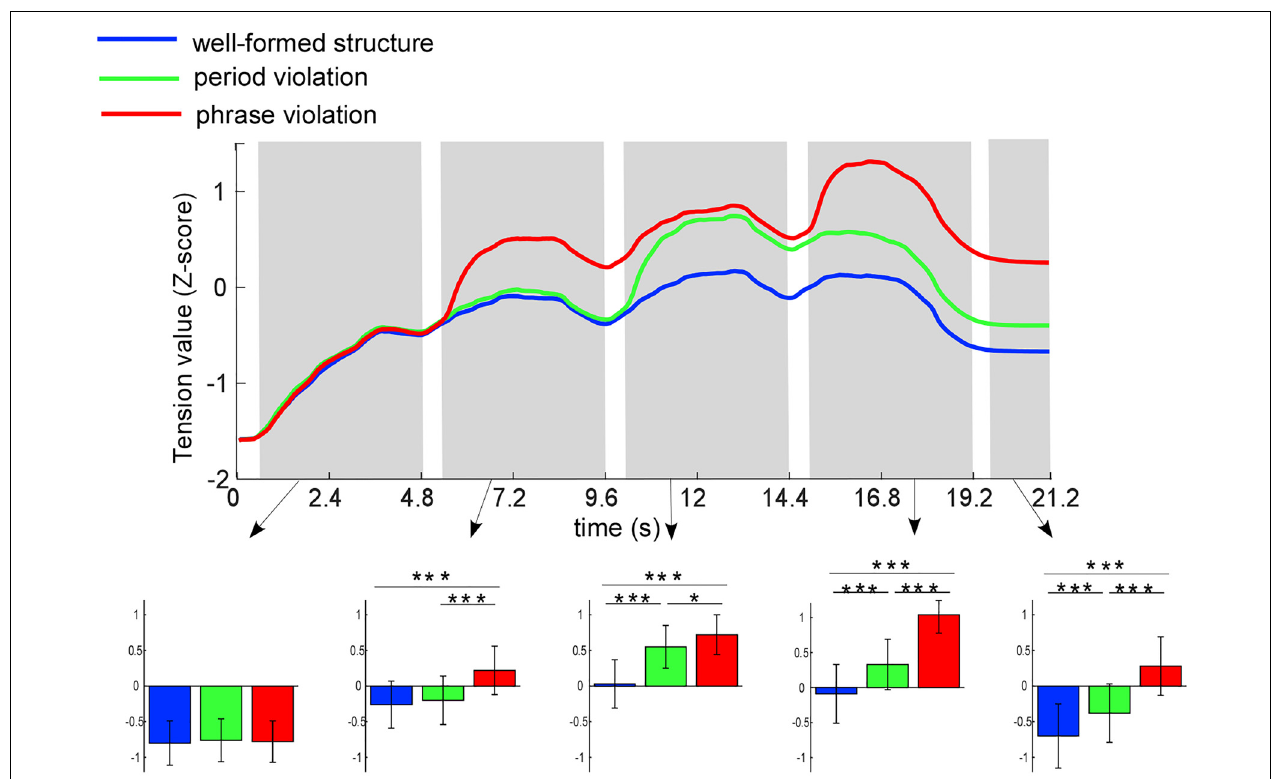
FIGURE 2 | Mean ratings ( z -score) of tension values for the three conditions at each time point. Five time-windows are analyzed: 0.5–4.8, 5.3–9.6, 10.1–14.4, 14.9–19.2, and 19.7–21.2 s, which marked in gray bars. Colored bars represent the mean of the tension values for the three conditions (expressed as mean ± SD). * p < 0.05; *** p <